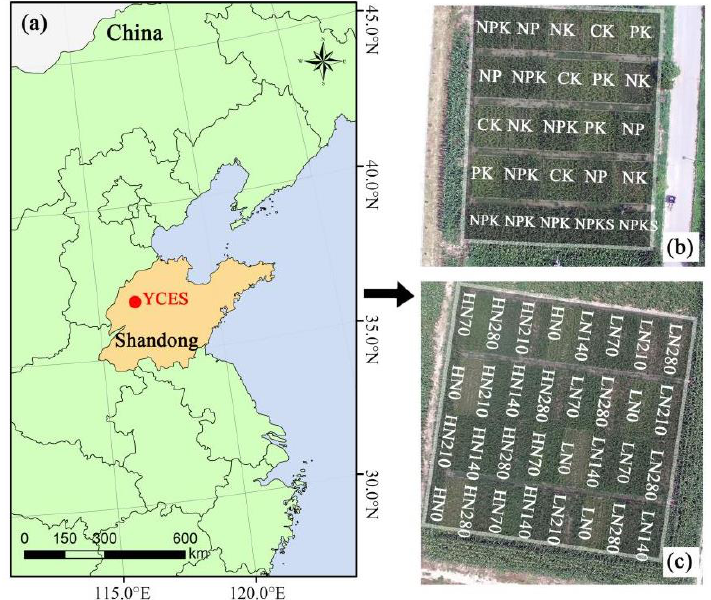
Figure 2. ( a ) Location of the YCES of the Chinese Academy of Sciences; ( b ) overview of NBES field; ( c ) overview of WNCR field. (N, P, K denote nitrogen, phosphate, and potash fertilizer, respectively, and S denotes returning all straw to field; CK is no NPK fertilizer; N0, N70, N140, N210, and N280 denote that 0, 70, 140, 210, and 280 kg·N·ha −1 were applied for each growing season, respectively; L and H denote 100 mm and 140 mm irrigation, respectively).